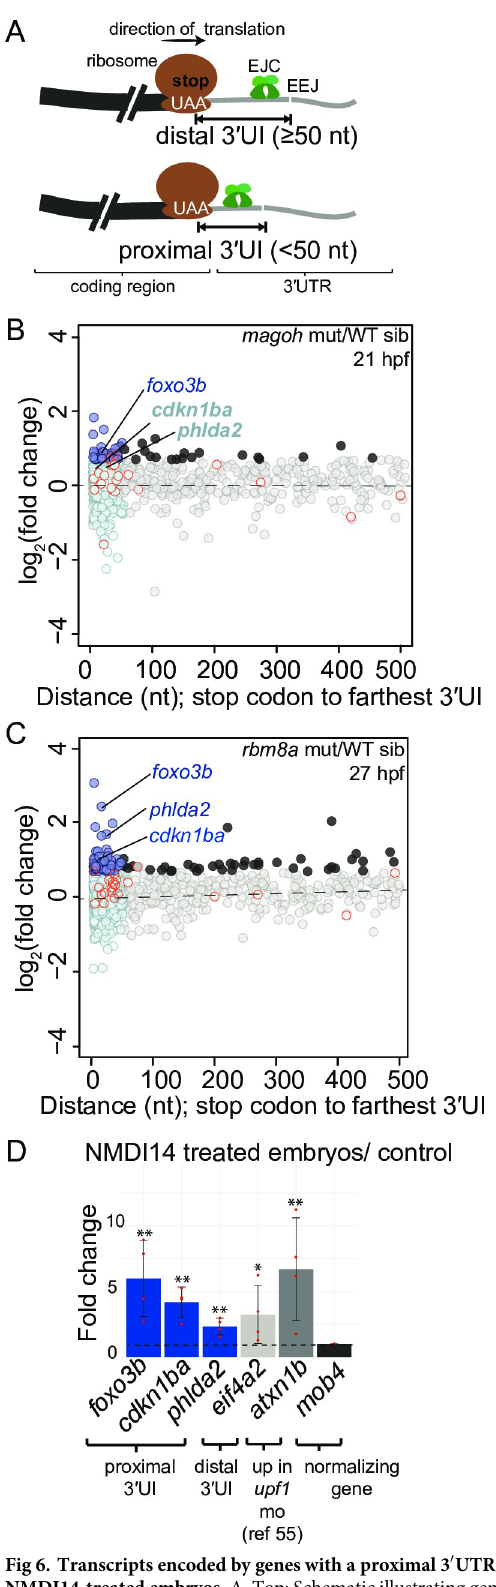
Fig 6. Transcripts encoded by genes with a proximal 3 0 UTR intron are upregulated in EJC mutant and in NMDI14-treated embryos. A. Top: Schematic illustrating genes with 3 0 UTR introns (3 0 UI) where the